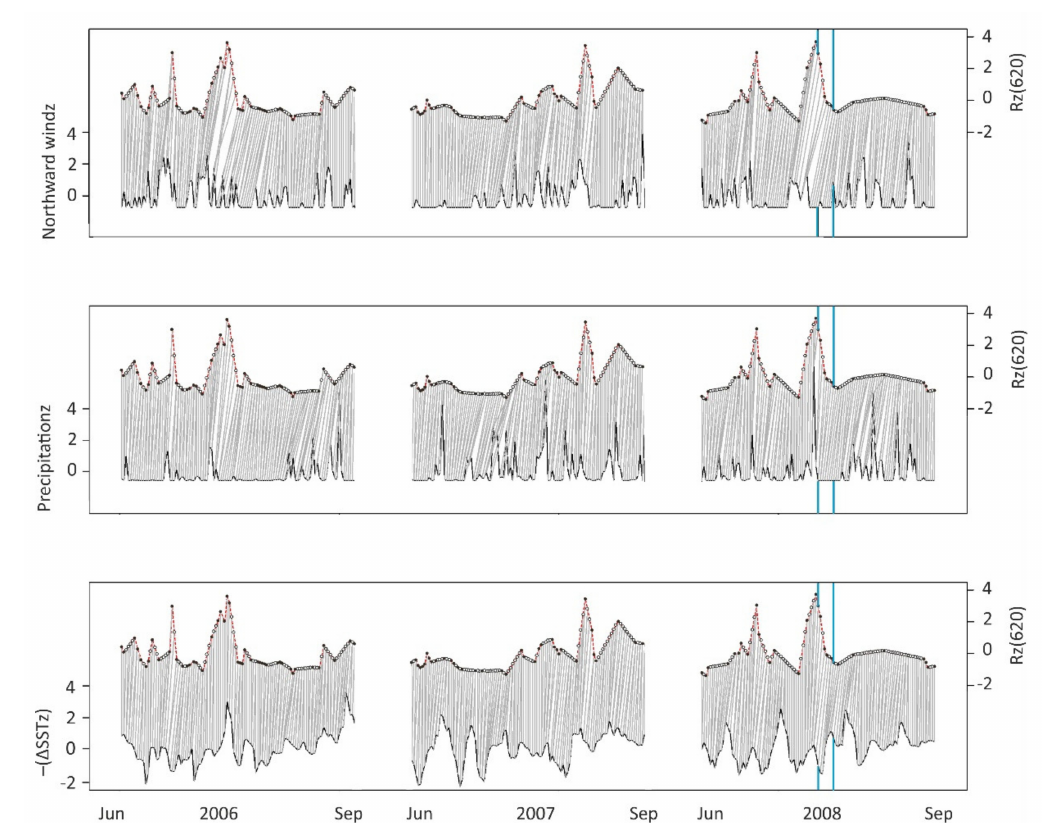
Figure 6. Examples of DTW alignments of standardized northward wind component, precipitation and –( ∆ SST z ) with R z (620) during 2006–2008 on the eastern coast of the Bothnian Sea (for location, See Figures 1 and 5). Note that –( ∆ SST) is the opposite of SST change, i.e., a positive value means a change to the colder. The scales are displaced for clearer presentation. The missing values of R rs ( λ ) time series (open dots) are interpolated according to neighboring observations in time (red dots). Missing values are seen especially in the late summer of 2008. The blue vertical lines in 2008 refer to MERIS RGB imagery at 24 July 2008 and 31 July 2008 in Figure